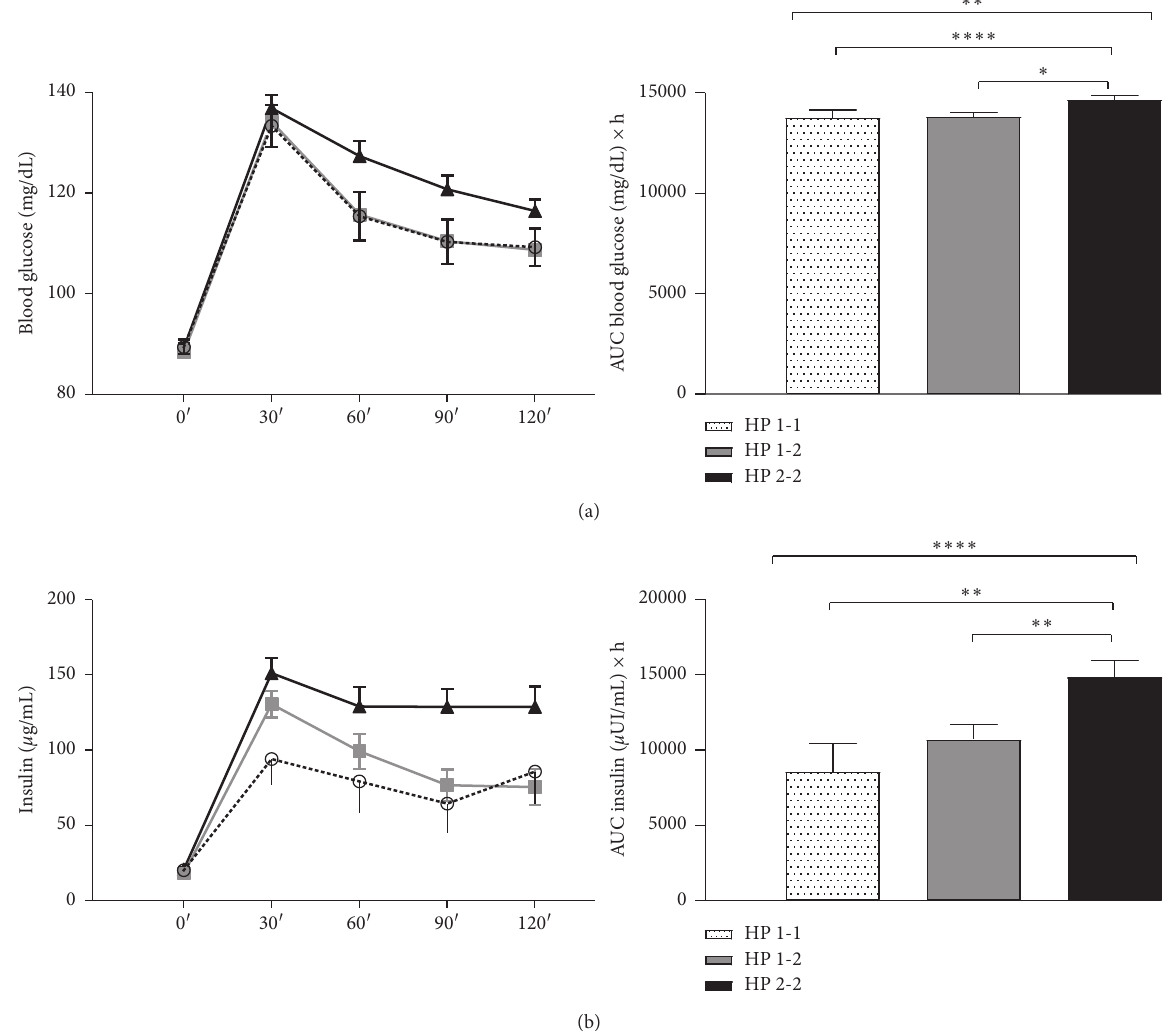
Figure 3: Postload glucose and insulin levels among Hp phenotypes. (a) Glucose levels (mg/dL) at each time point and as AUC (mg/dL × h) at OGTT among Hp phenotypes. (b) Insulin levels (mg/dL) at each time point and as AUC (mg/dL × h) at OGTT among Hp phenotypes. Data are expressed as mean ± SD. AUC � area under the curve. Phenotype 1-1: speckled line and bar; phenotype 1-2: grey line and bar; phenotype 2-2: black line and bar. ∗ p < 0 . 01; ∗∗ p < 0 . 02; ∗∗∗∗ p < 0 . 04; ∗∗∗∗∗ p < 0 .